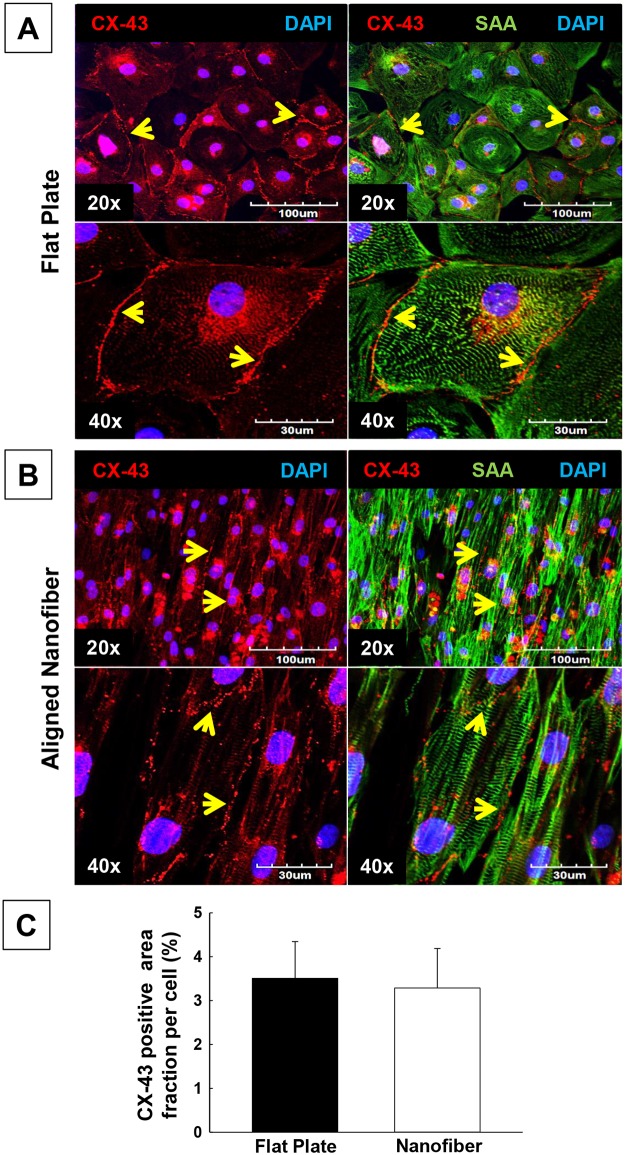
Analysis of gap junctions in hiPSC-CMs by confocal microscopy in cells seeded on flat plate and aligned nanofiber.The gap junctions in hiPSC-CMs was evaluated by CX-43 immunostaining of human cardiomyocytes seeded on flat surface versus aligned-nanofiber coated coverslips. A) Flat plate, CX-43 (Red), SAA (Green) and DAPI (Blue); B) Aligned nanofiber, CX-43 (Red), SAA (Green) and DAPI (Blue); C) Quantification of gap junctions (% CX-43 positive area fraction per cell) in hiPSC-CMs seeded on flat plate and aligned nanofiber. There were no significant differences between the two groups. All values expressed as mean ± SD (n = 4/group).